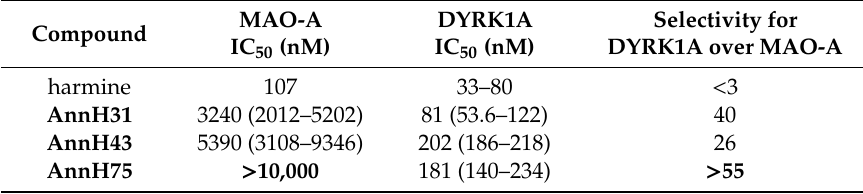
Table 2. Inhibition of MAO-A and DYRK1A by selected β -carbolines (95% confidence intervals in